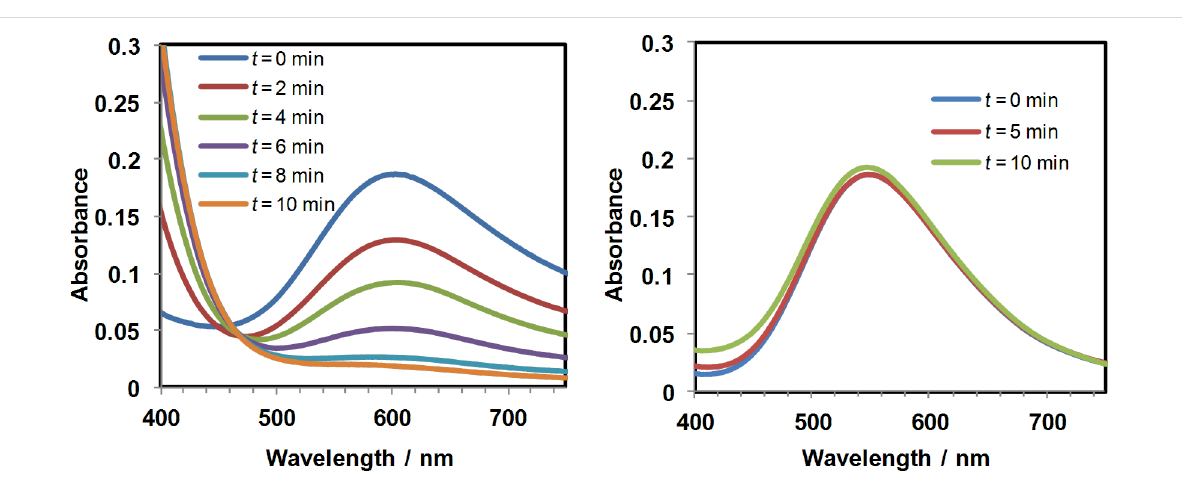
Figure 2: Evolution of the UV–vis spectra of deaerated (freeze-pump-thaw degassed, sealed quartz cuvettes) THF (left) or water (right) solutions (3 mL) of complex 1 (2 mM) under irradiation at 365 nm using a TLC lamp placed at ≈ 1 cm from the cuvette.